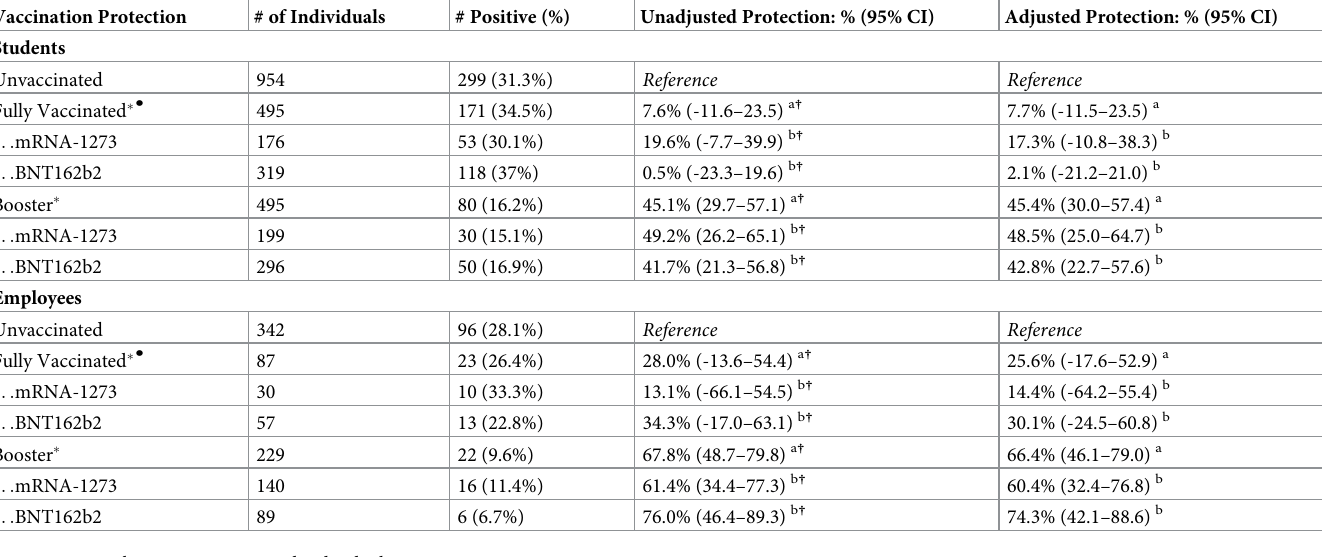
Table 3. Estimated protection from vaccination against any SARS-CoV-2 infection between January 3 rd -31 st , 2022. Vaccination